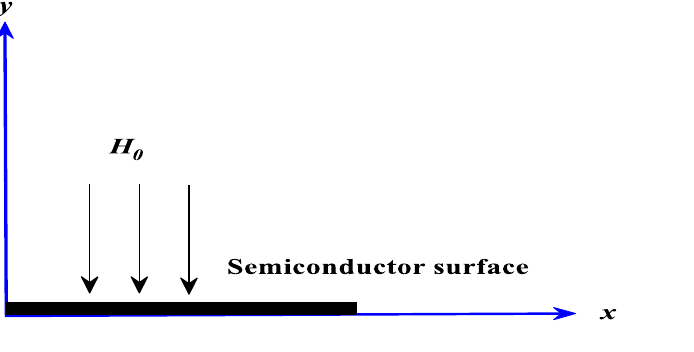
Figure 1. Schematic of the